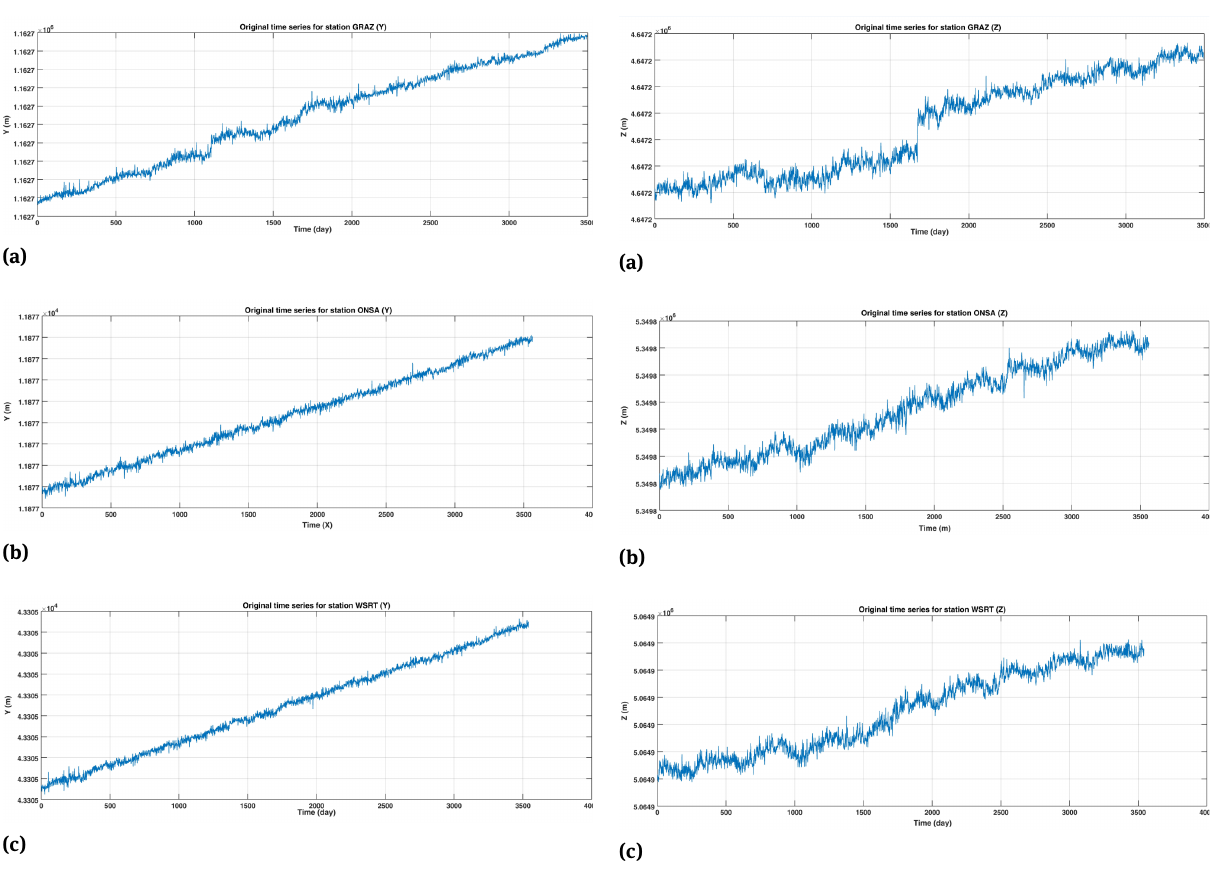
Figure 5: Original time series of parameter Y for station (a) GRAZ, (b) ONSA, (c) WSRT.